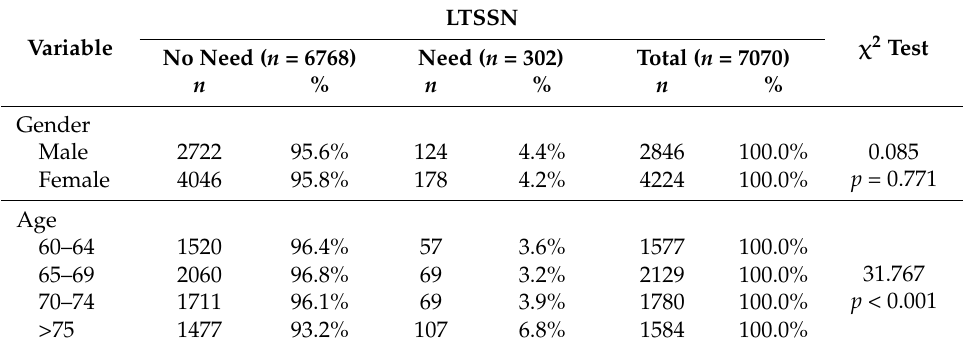
Table 2. Characteristic of Participants by